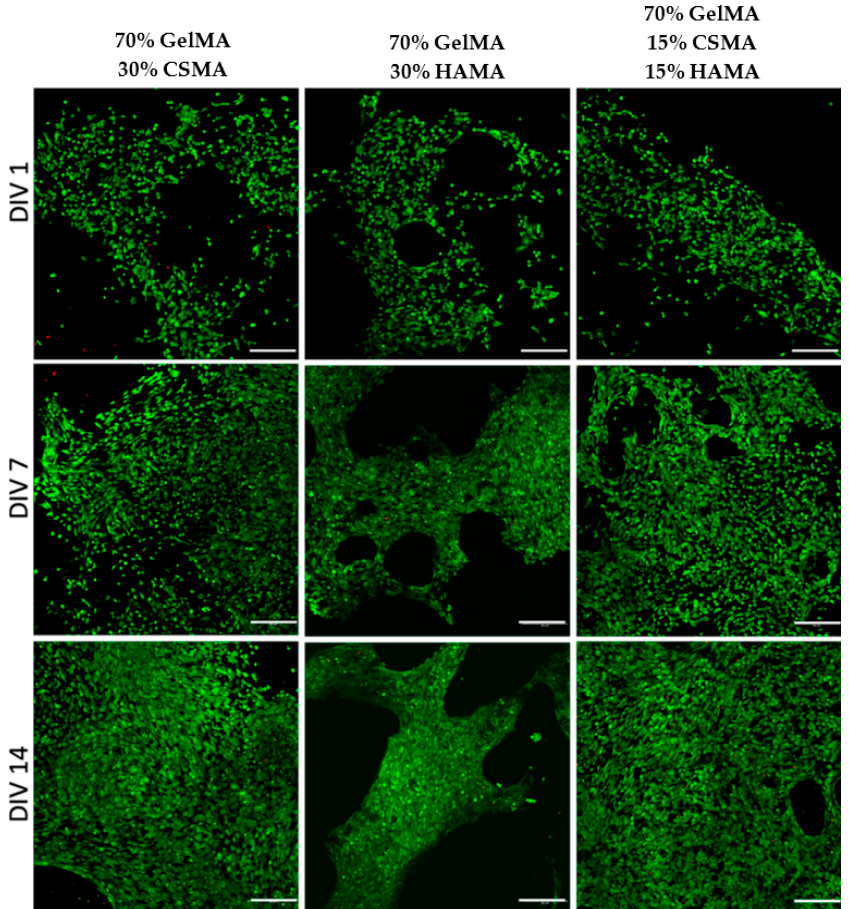
Figure 8. Confocal images of live (green)/dead (red) assay for the ATDC-5 cells seeded on the di ff erent GelMA–based hydrogels at 1, 7 and 14 days in culture. The bar represented 200 µm.